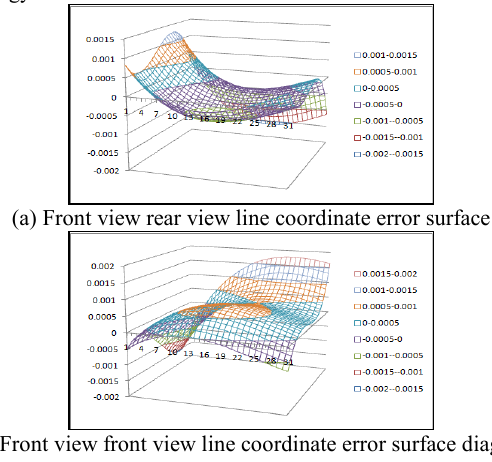
Figure 4 Statistics of relative error between projection lines coordinates and reference line coordinates (ZY-3 whole scene image